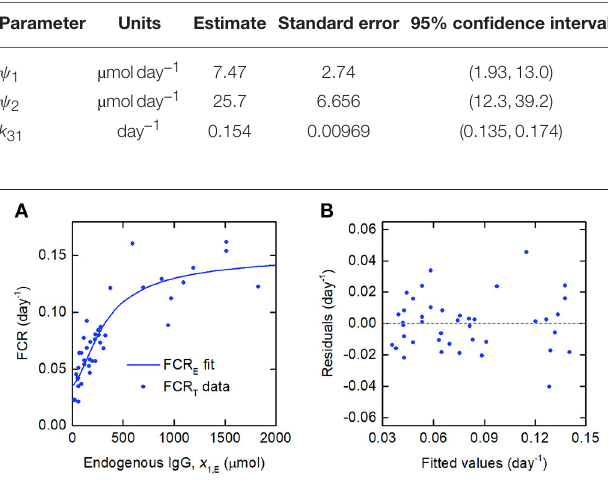
FIGURE 6 | (A) Expression for FCR E vs. x 1,E , given by Equation (29), fitted to FCR T vs. x 1,E data from Waldmann and Strober (21). (B) Residuals vs. fitted